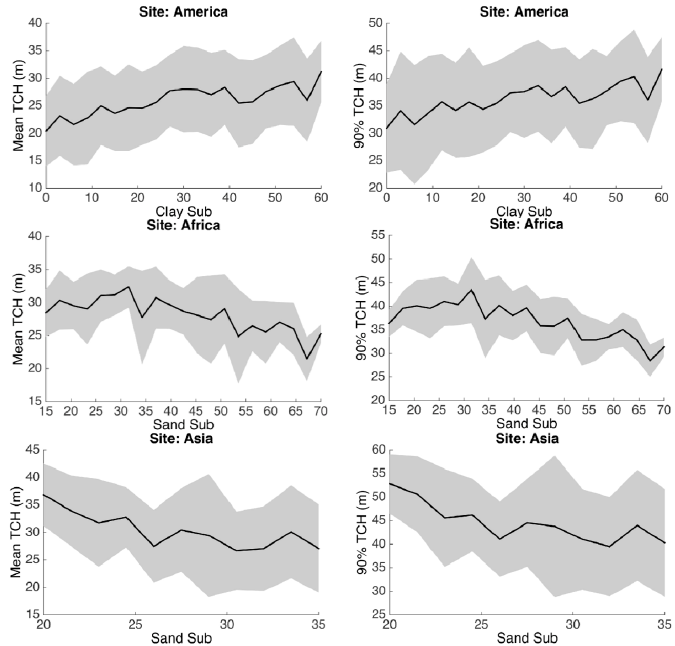
Figure 6. Tree height (TCH m and TCH 90 ) variations with soil physical properties. The clay content in America and sand content in Africa and Asia are selected as they are all significant variables in the spatial regression results. The height metrics are binned up to 20 groups along the X axis to get the mean and standard deviation.